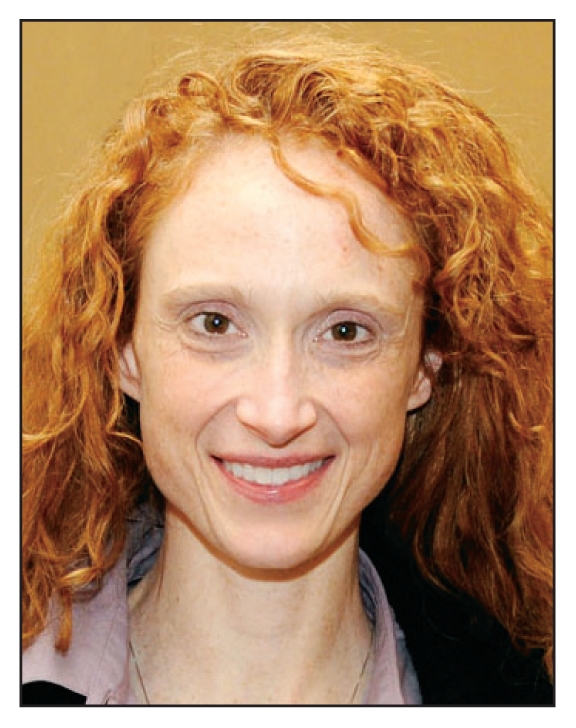
Kristina Thayer